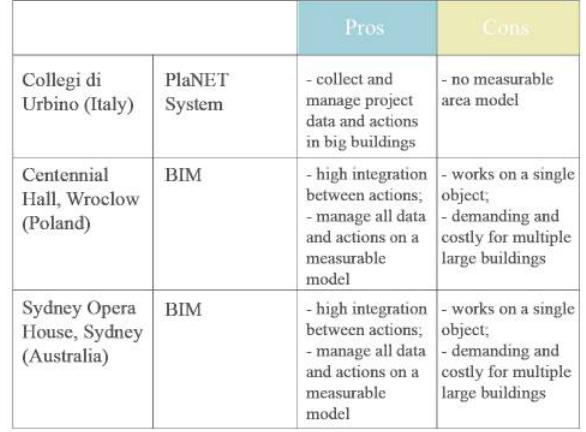
Table 2. Pros and Cons of advanced geomatics for 20 th century architecture and for CMP